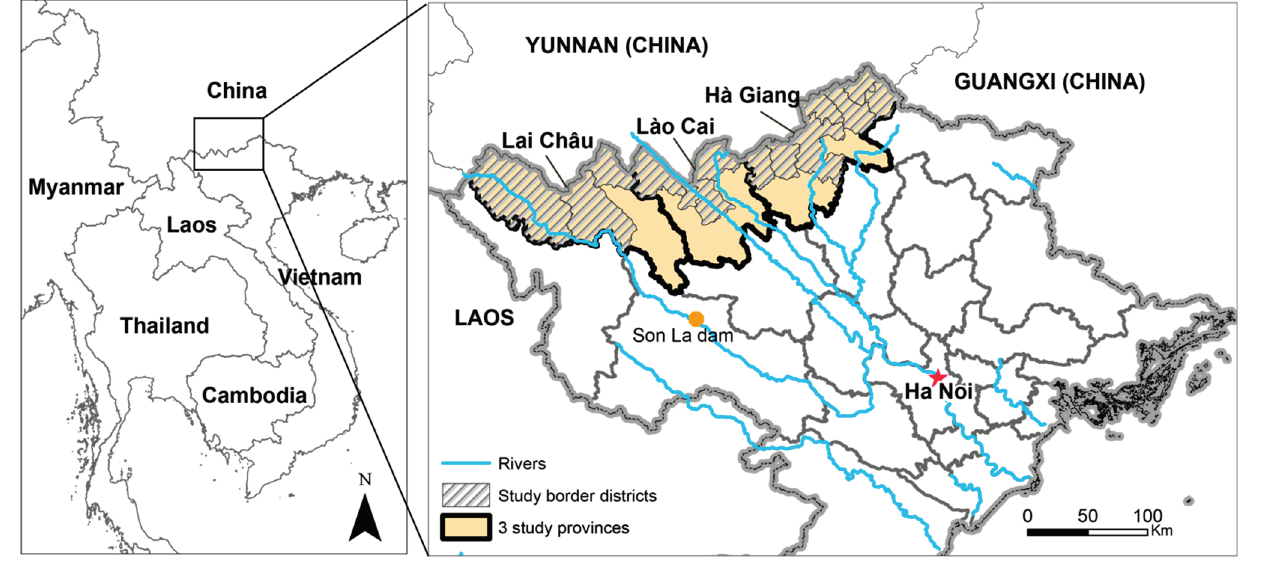
Figure 1. Location of the study border districts and provinces in northern